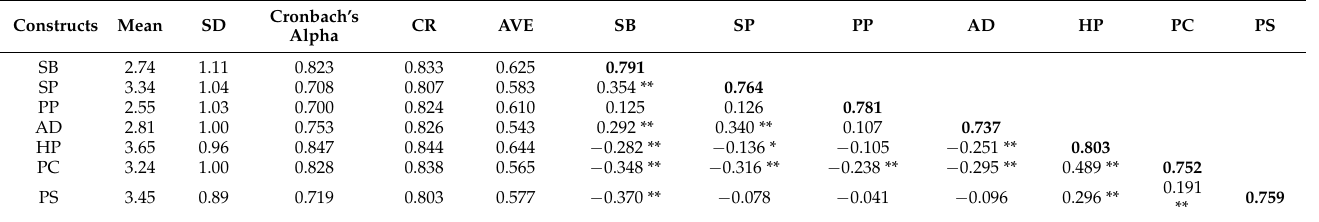
Table 3. Cronbach’s alpha, composite reliability, AVE, and correlations.